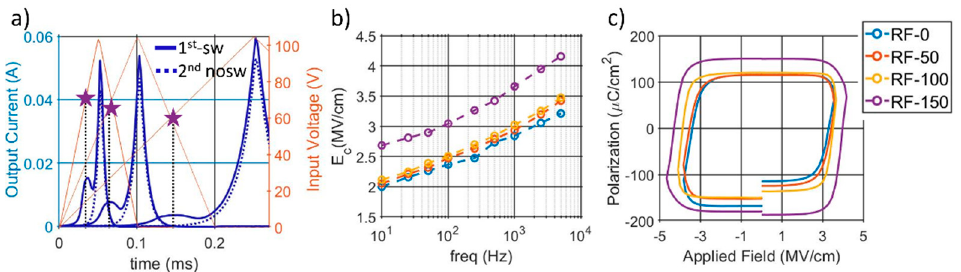
Figure 6. ( a ) Examples of switching (continuous) and non-switching (dotted) currents (blue curves) for different input frequencies, along with the corresponding coercive field extraction method. ( b ) Summary of coercive fields for all the switchable samples from 10 Hz to 5 kHz. ( c ) Extracted P-E loops with a 5 kHz input voltage.